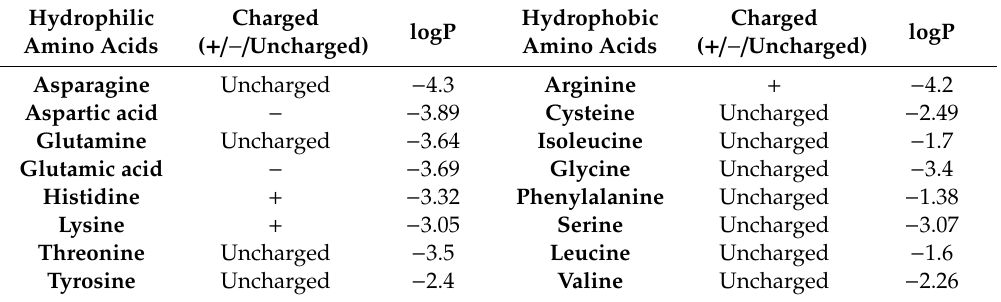
Table 3. List of di ff erent hydrophilic and hydrophobic amino acids with corresponding logP values. The lipophilicity of these amino acids, expressed as their logP, ranges from − 4.3 to − 1.38, where asparagine with logP value of − 4.3 being the least lipophilic and phenylalanine with a logP of − 1.38 being the most lipophilic or hydrophobic amino acid. It also shows that hydrophilic amino acids are either charged, uncharged or polar molecules, while hydrophobic amino acids are mostly uncharged and